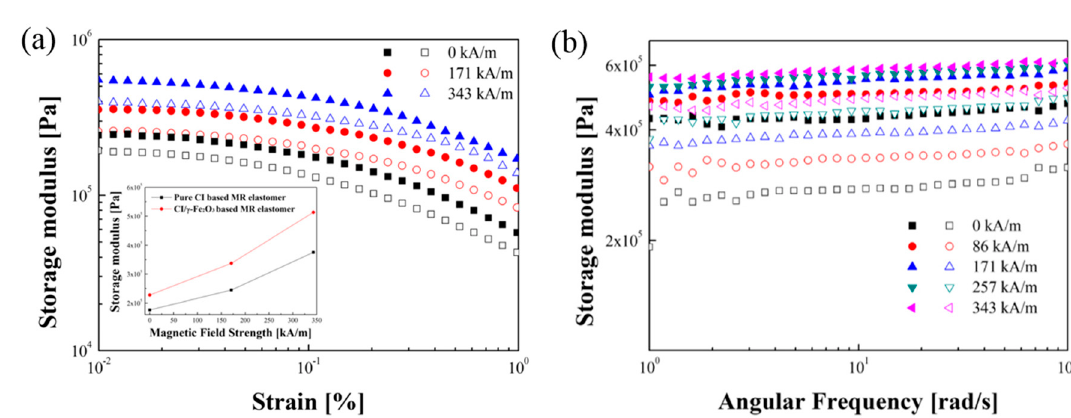
Figure 7. ( a ) Storage Modulus versus strain amplitude sweep and ( b ) storage modulus versus angular frequency sweep (Closed symbol:CI / γ -Fe 2 O 3 based MRE, open symbol: Pure CI based MRE) [121].